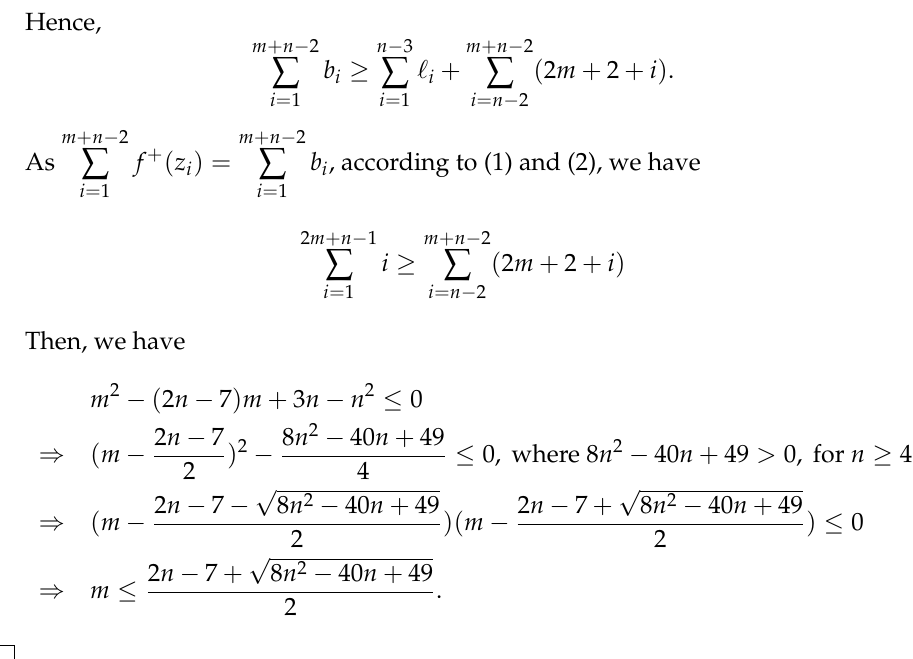
Figure 1. Notations for vertices in mP 3